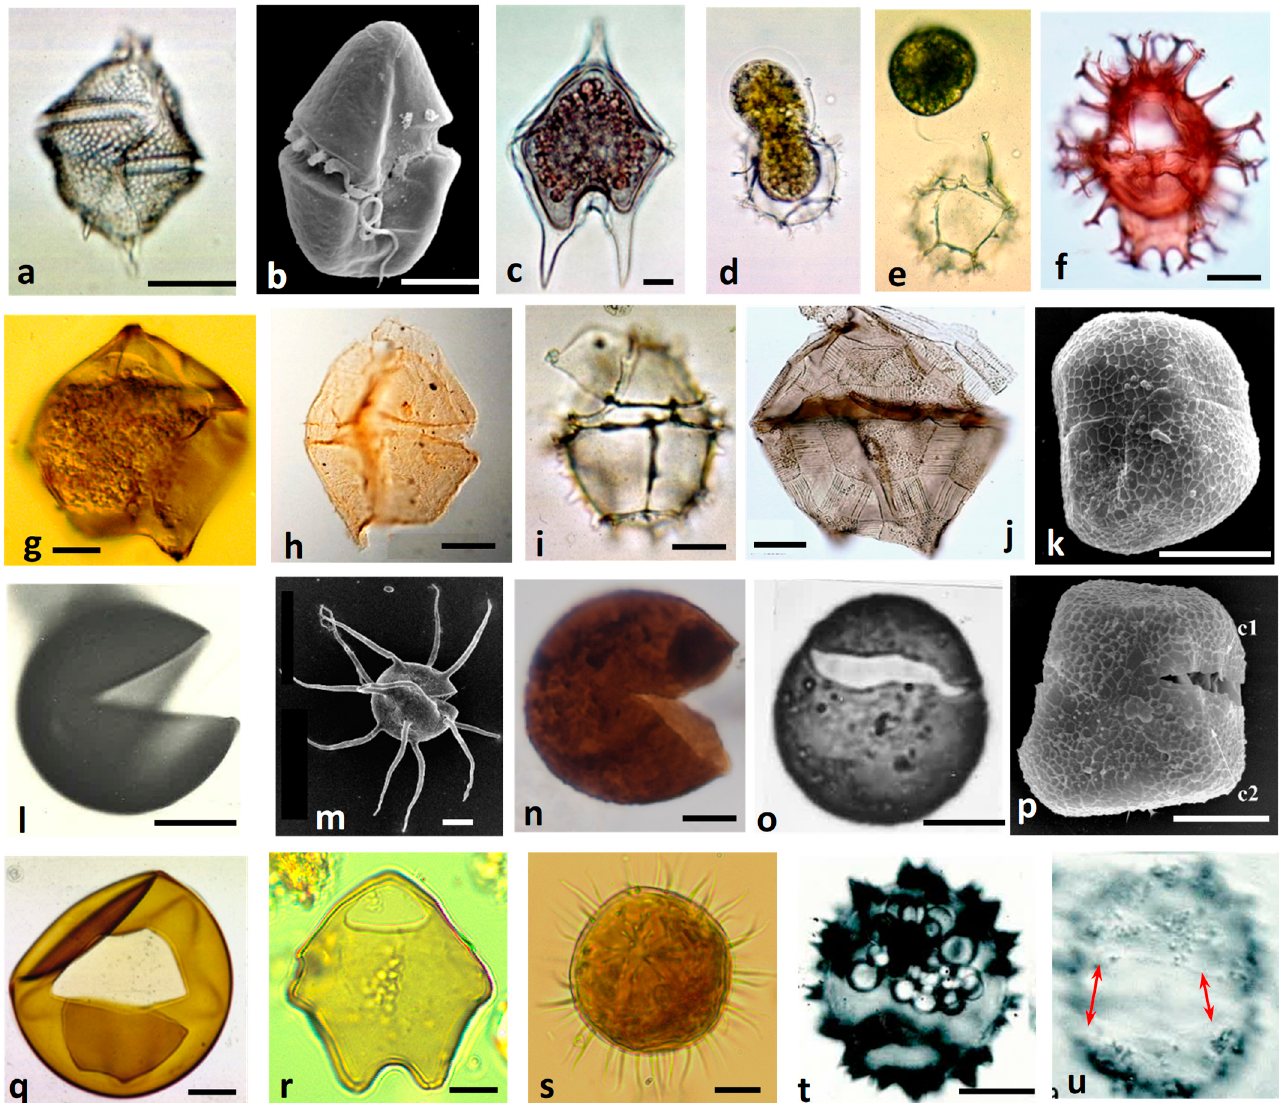
Figure 1. Living and fossil dinoflagellates. ( a , b ) living motiles; ( a ) thecate ( Gonyaulax ), ( b ) athecate ( Gymnodinium trapeziforme ); ( c ) cyst-formation in planozygote ( Protoperidinium) ; ( d , e ) excystment, note amoeboid stage exit ( Gonyaulax ); ( f ) living cyst with robust processes ( Gonyaulax ); ( g – u ) cysts; ( g , h ) reflecting motile stage morphology, ( g ) living cyst with protoperidiniod body shape, ( h ) fossil cyst with same body-shape ( Subtilisphaera L. Cretaceous), ( i ) living cyst with reflected tabulation ( Gonyaulax ), ( j ) fossil cyst with reflected tabulation ( Palaeoperidinium, U. Cretacous); ( k ) living cyst of athecate Gymnodinium trapeziforme showing trapezoidal body-shape , reticulate ornamentation reflecting alveolae and cingulum and sulcus, ( l ) living cyst of thecate Diplopsalopsis latipeltata showing split archeopyle, ( m ) fossil cyst with split archeopyle (U. Cretaceous), ( n ) acritarch with split archeopyle (Lowermost Silurian), ( o ) living cyst of thecate Diplopelta symmetrica with split-like archeopyle, ( p ) living cyst of athecate G. trapeziforme with split archeopyle; ( q – s ) features on living cysts showing dinoflagellate affinities; ( q ) only archeopyle shows dinoflagellate affinity ( Protoperidinium ), ( r ) body-shape and archeopyle ( Protoperidinium ), ( s ) typical spherical spinose cyst that would be “acritarch” if archeopyle not evident ( Gonyaulax ); ( t , u ) athecate cyst with split archeopyle that would be “acritarch” if archeopyle not evident (arrows show archeopyle margin). Scale bar = 10 µm: ( b , f , h , i , k , m , p , r – u ); 20 µm: ( a , j , l , n , o , q ). See text for more detailed explanations of features shown. Images ( a , c – g , i , l , o , q – u ) by the author; see acknowledgements for other credits.